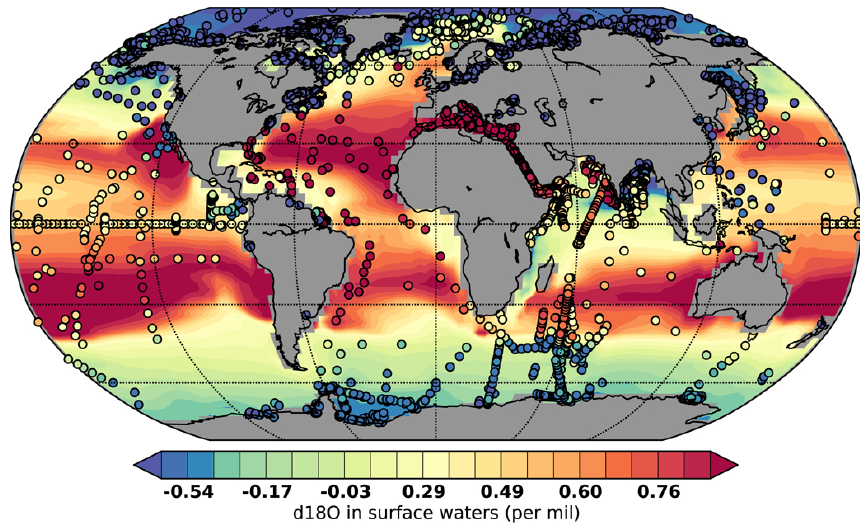
Fig. 8. Near-surface ocean δ 18 O in sea water in i LOVECLIM compared to the GISS database (Schmidt et al., 1999) (coloured circles).